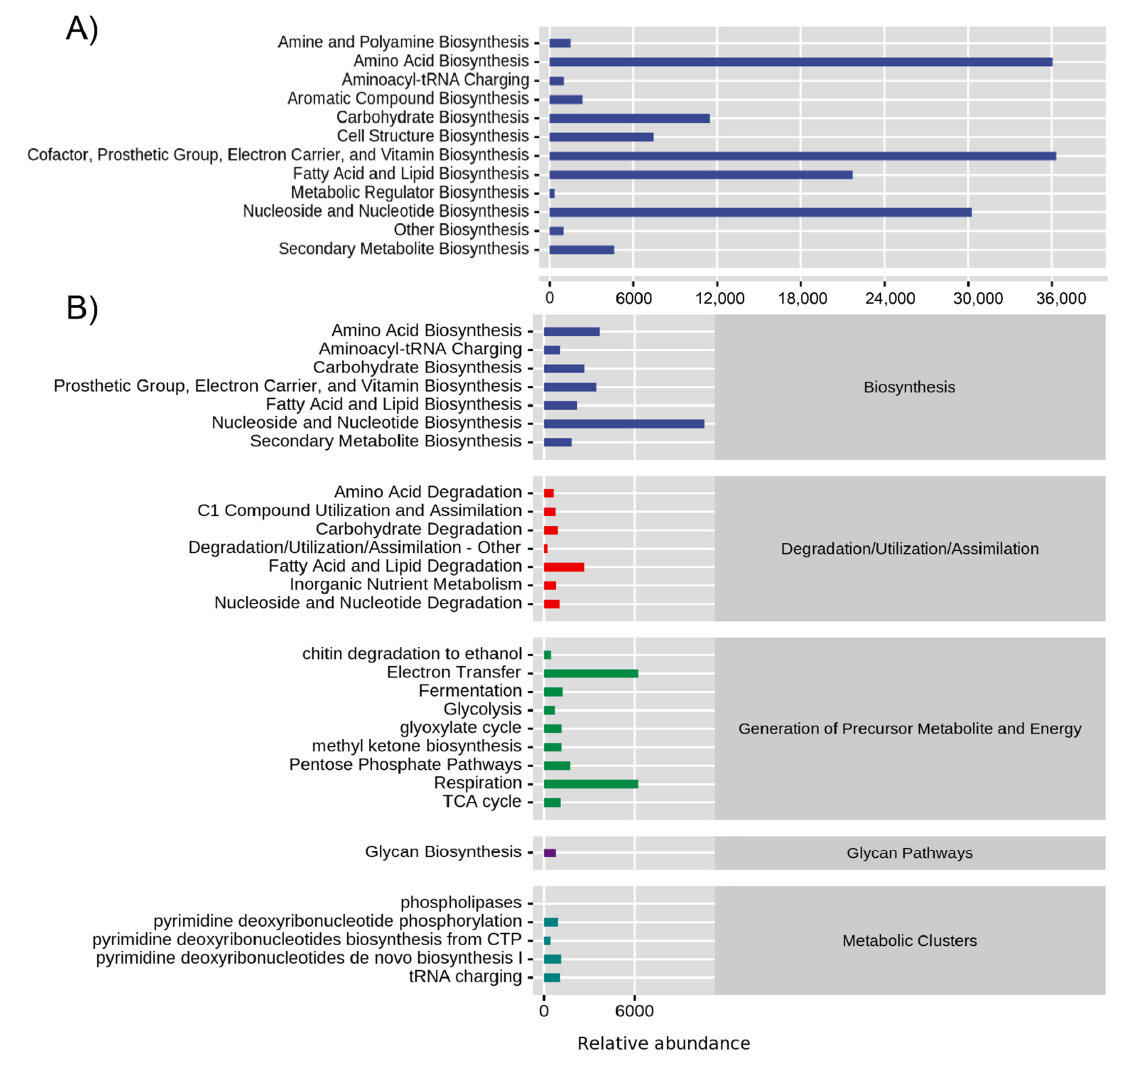
Figure 6. Seed endophytic bacterial ( A ) and fungal ( B ) community functional abundance prediction based on MetaCyc genome database. The horizontal axis is the relative abundance of the functional pathway (unit is the PWY (pathways involved in metabolism) per million) of the second classification level of MetaCyc, and to the right is described the first-level pathway to which this functional pathway belongs. Functional pathway refers to the average abundance of all samples, and detailed information is described in Figure 1.